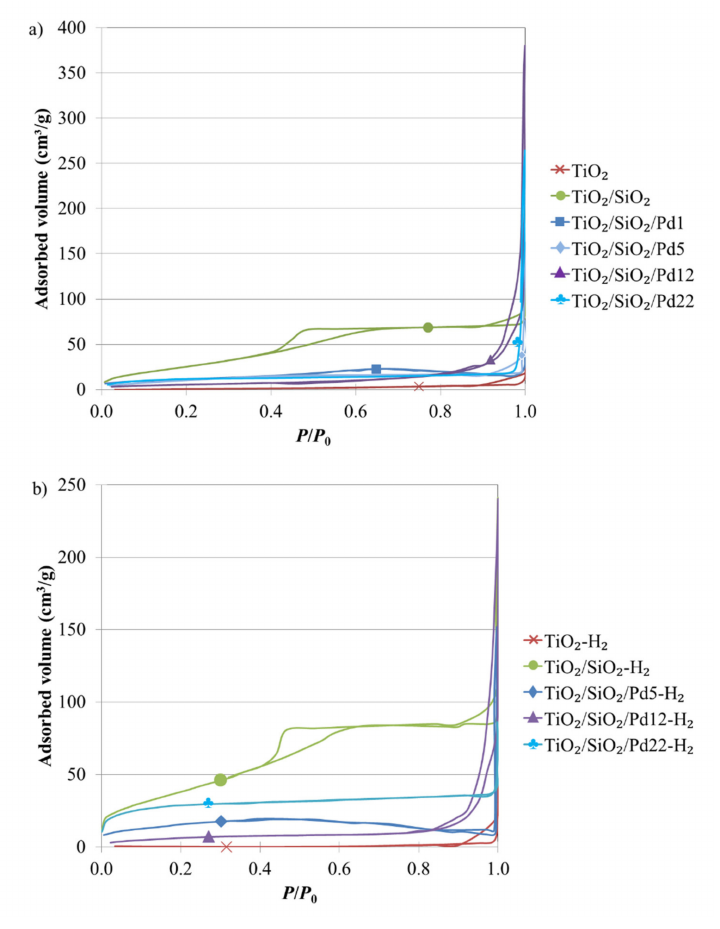
Figure 2. Nitrogen adsorption–desorption isotherms of ( a ) calcined samples and ( b ) reduced samples.